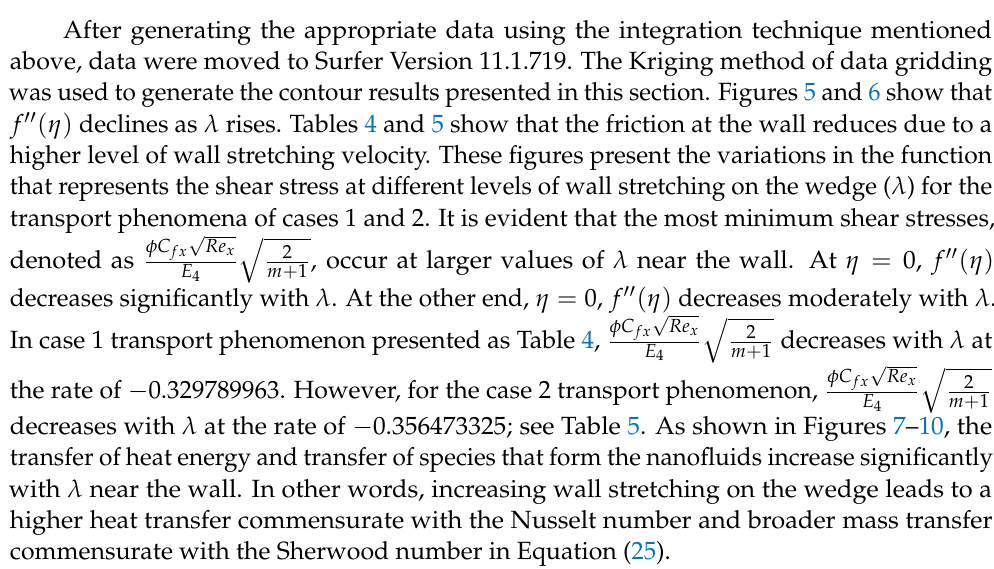
Figure 4. Effect of wall stretching velocity λ on the temperature distribution within the dynamics of both nanofluids when m = 0.1.